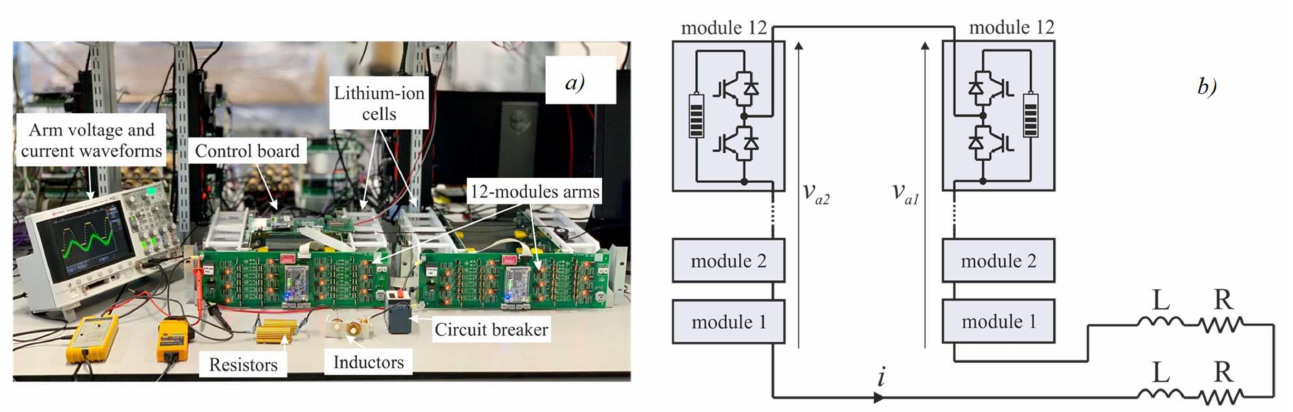
Figure 5. Experimental setup: ( a ) Photograph and ( b )